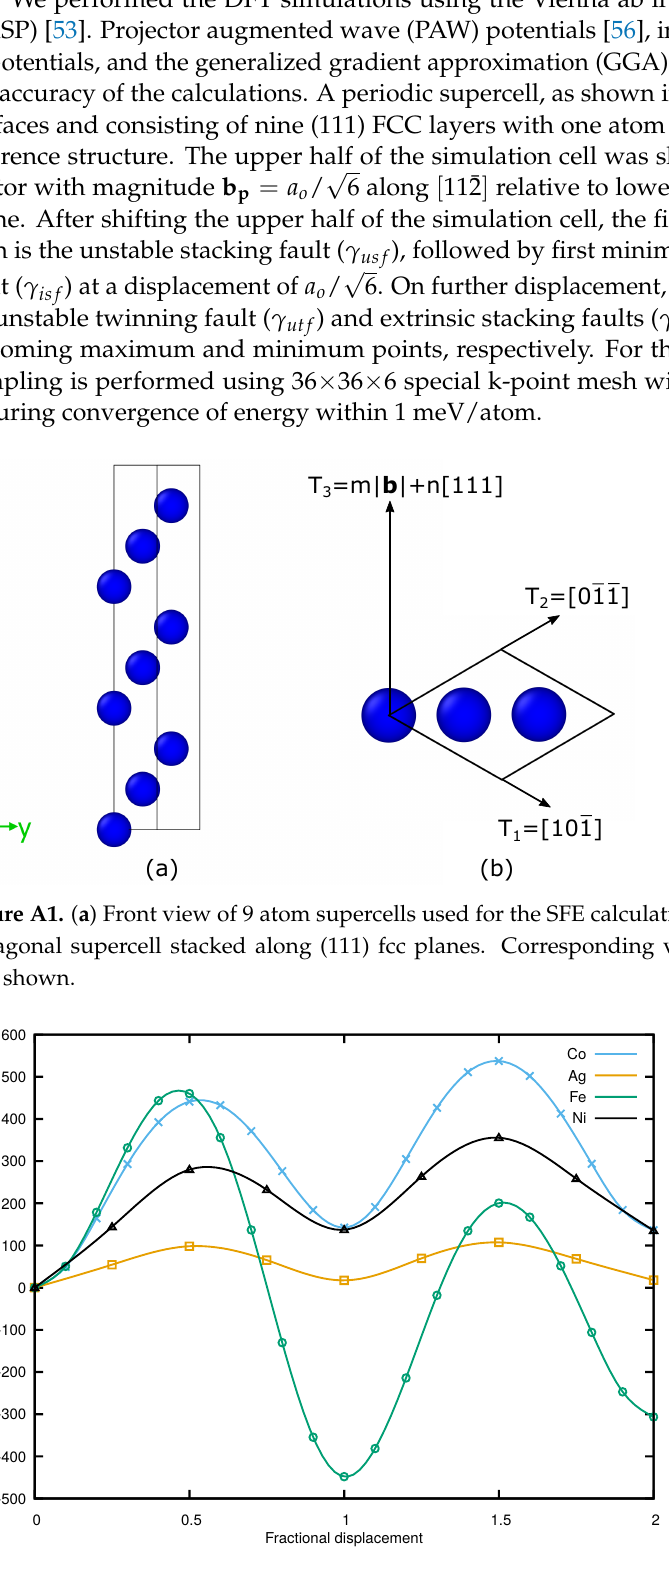
Figure A2. Generalized stacking fault energy curves for the